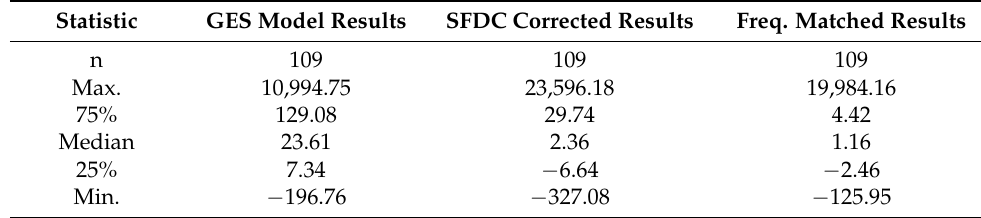
Table 1. Mean error summary statistics for the Magdalena River.